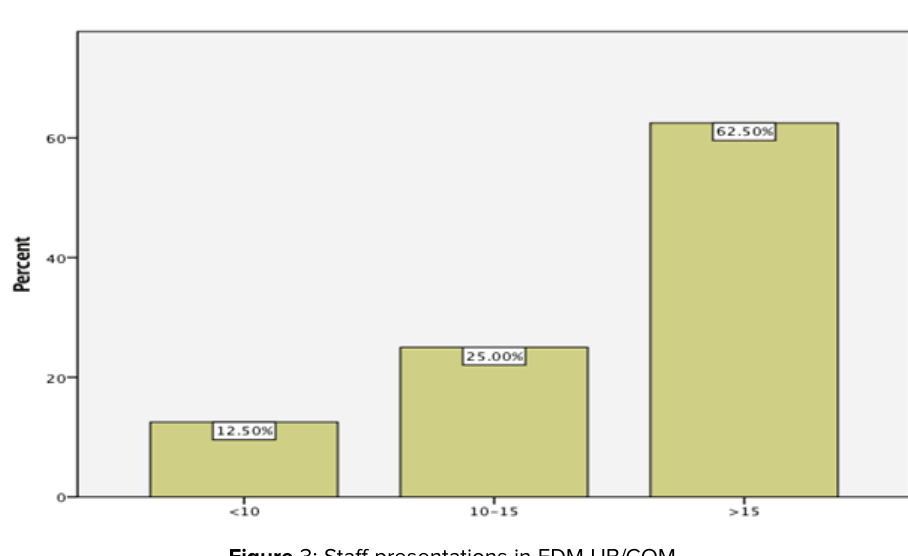
Figure 3: Staff presentations in FDM UB/COM.